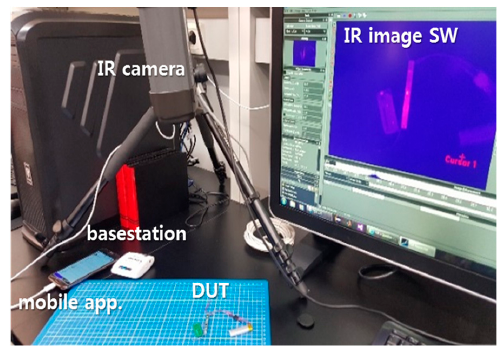
Figure 20. Measurement setup for measuring the temperature distribution on the SoB.